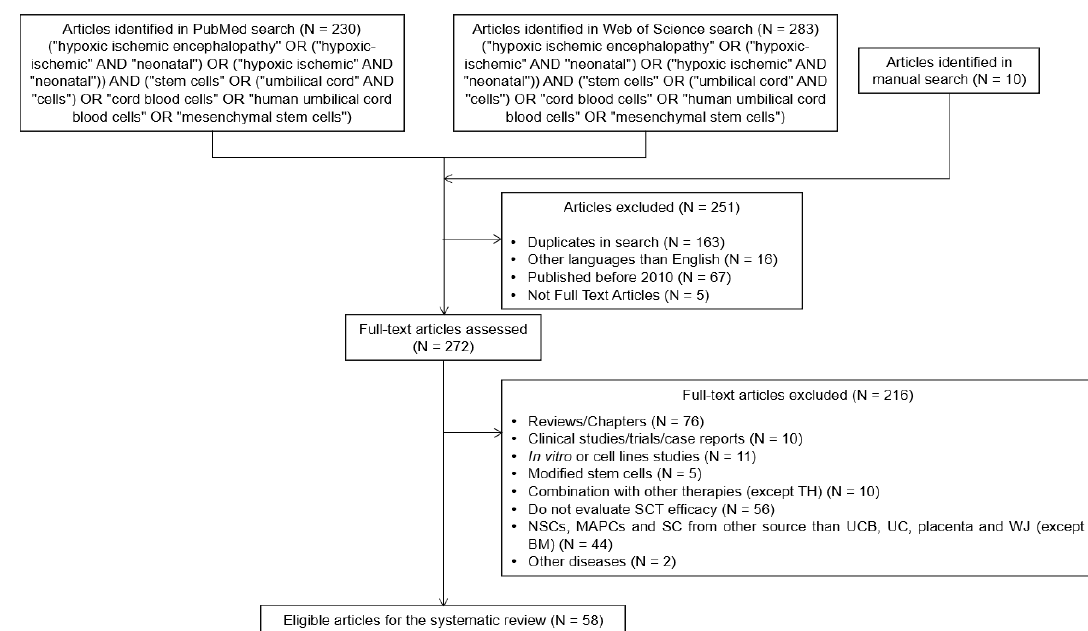
Figure 6. Flow diagram representing the literature search and screening processes applied to select the preclinical studies included in this systematic review. Abbreviations: BM—bone-marrow; MAPCs—multipotent adult progenitor cells; NSCs—neuronal stem cells; SC—stem cells; UC—umbilical cord; UCB—umbilical cord blood; WJ—wharton’s jelly.